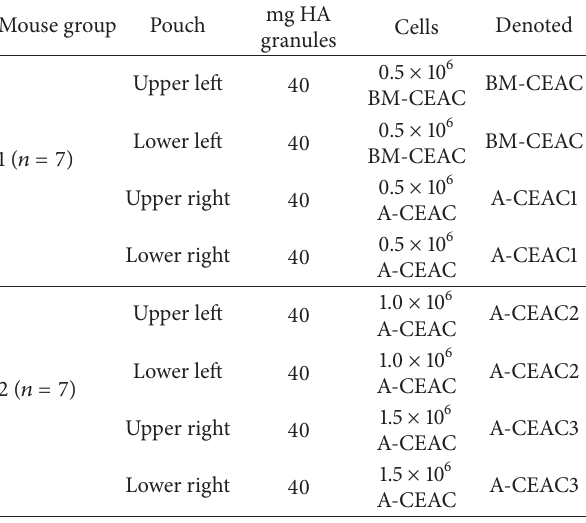
Table 1: Animal and implant groups. Cells were seeded on 40 mg HA scaffold as previously described